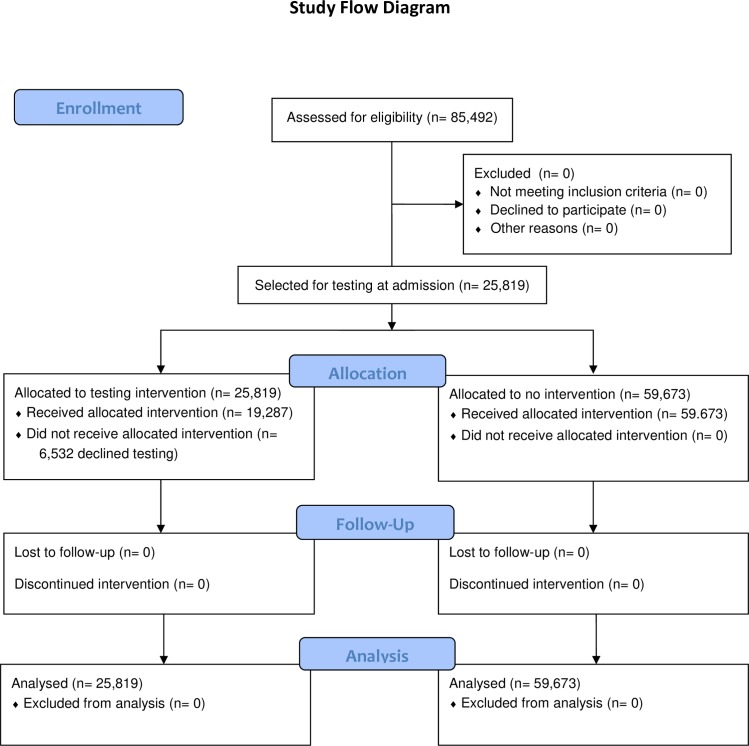
Participant flow diagram for the intervention portion of this report.